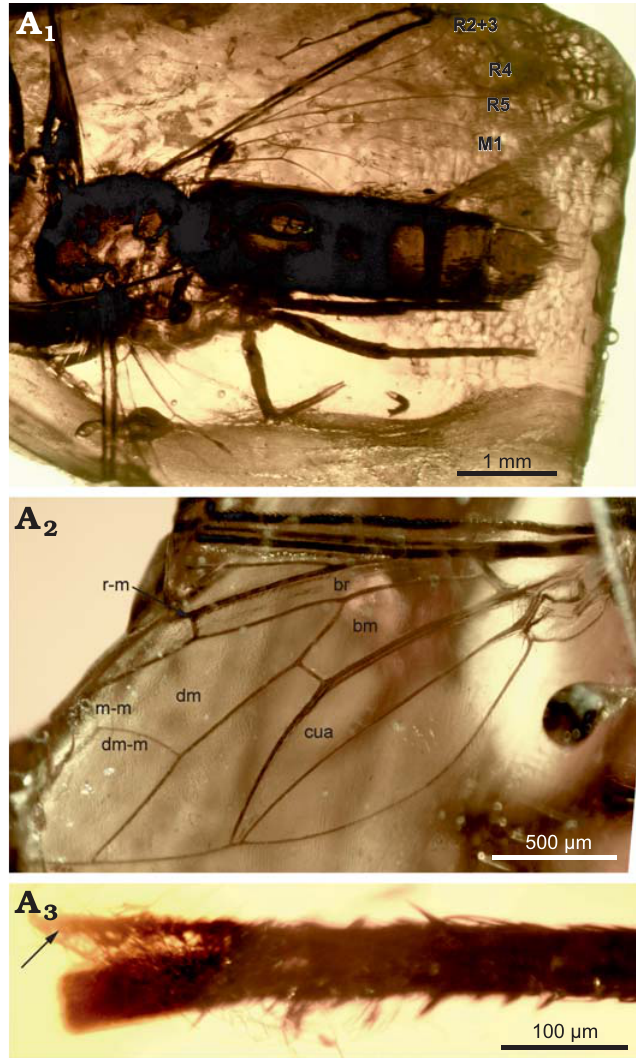
Fig. 1. Bombyliid bee fly Eoconophorina delfineae gen. et sp. nov., holo- type MNHN.F.A71306; earliest Eocene, Oise amber, France. Habitus above ), left wing (A ), mid tibia (A , arrow indicates spur). Abbreviations: (A 1 2 3 bm, basal medial cell; br, basal radial cell; cua, cubital cell; dm discal cell; dm-m discal-medial crossvein; m-m medial crossvein; r-m radial-median crossvein; M1, first branch of median vein; R2+3, second + third branch of radial vein; R4, fourth branch; R5, fifth